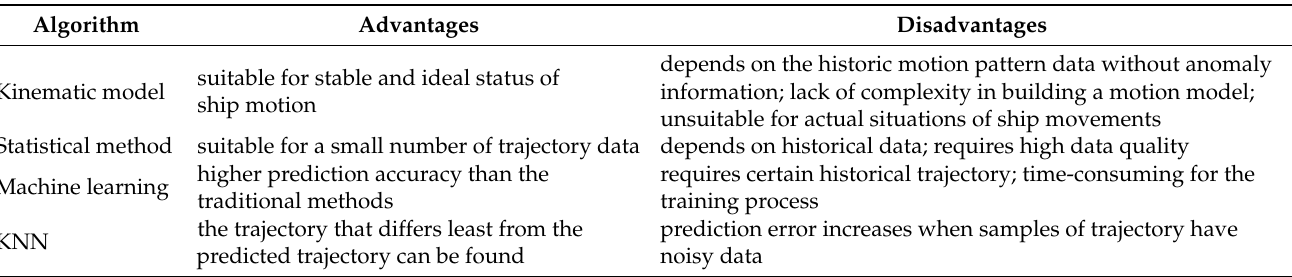
Table 1. The advantages and disadvantages of the algorithms.